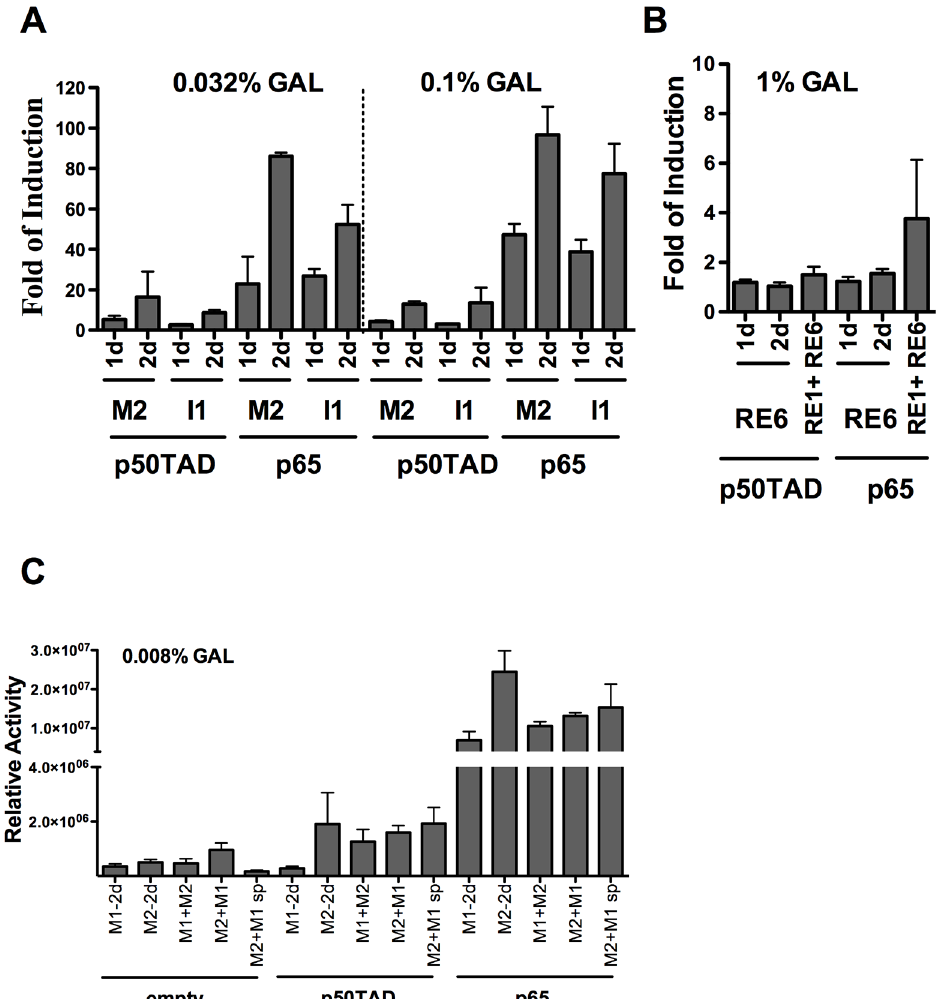
Fig 2. Additive or weak cooperative transactivation between adjacent κ B REs. A) Yeast-based luciferase assays were performed at moderate to high expression levels of p50TAD or p65. Results were normalized and plotted as in Fig 1. The impact of tandem duplication (2d) of the decameric (1d) κ B-RE or the indicated combination of two different κ B-REs was evaluated. The REs were chosen based on the results from Fig 1 to include sequences exhibiting different levels of transactivation potentials. B) RE1 and RE6 were inactive as decameric κ B-REs and there was no transactivation for two decamers in tandem or high expression of NF- κ B proteins (up to 1% galactose). C) Functional interactions between two different κ B-REs derived from the MCP-1 promoter. The M1 and M2 decameric κ B-REs exhibited different responsiveness to p50TAD and p65, when examined separately, but are both derived from the MCP-1 promoter and they are located in close distance (19 nucleotide spacer) in the natural context. The combined responsiveness of the M1 and M2 κ B-REs was examined, taking into account the impact of the distance between the two decamers and orientation relative to the transcriptional start site. Tandem repeats of M1 or M2 were included as controls. Yeast reporter strains, transformed with the indicated expression vector were cultured for 16 hrs with the indicated low amount of galactose. Relative activity refers to the average light units normalized for cell number (measured by optical density at 600nm). Average and standard error of four biological repeats are presented. The NF- κ B-independent reporter activity (empty vector) is also presented as reference. Interestingly, the M2+M1 strains exhibited higher basal level of reporter expression. The M1+M2 sp strain contains the M1 and M2 κ B decamers separated by 18 nt as in the human gene (see Table A in S1